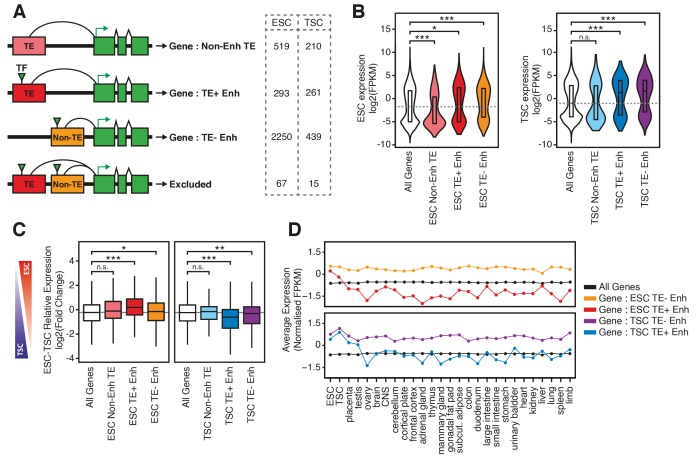
TE+ enhancers interact with tissue-specific genes.(A) Different types of elements were linked with genes and their expression levels based on PCHi-C data. Genes interacting with both TE+ and TE- enhancers were not considered. Numbers of gene promoters in each group are shown. (B) ESC and TSC expression levels for genes interacting with each of the groups indicated in A, and compared with the full distribution of expression levels (*p<0.05, ***p<0.001, ANOVA with Holm-Sidak’s post-hoc test). (C) Relative expression levels (ESC/TSC ratio) for genes expressed in at least one of the two cell types (*p<0.05, **p<0.01, ***p<0.001, ANOVA with Holm-Sidak’s test). (D) Average expression levels of ENCODE RNA-seq datasets from multiple tissues, compared with data from ESCs and TSCs. Data were normalised through distribution matching.